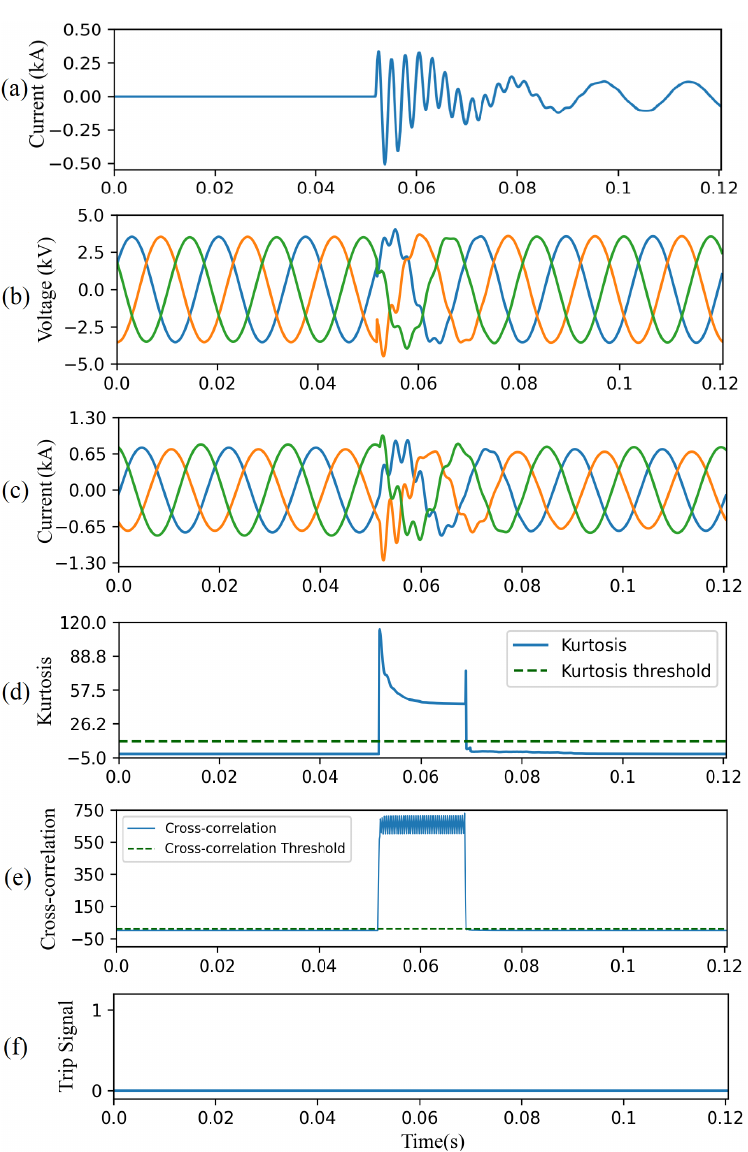
Figure 13. CAE-HIFD performance under a capacitor switching scenario: ( a ) capacitor current, ( b ) three-phase input voltages, ( c ) three-phase input currents, ( d ) kurtosis, ( e ) cross-correlation, and ( f ) trip